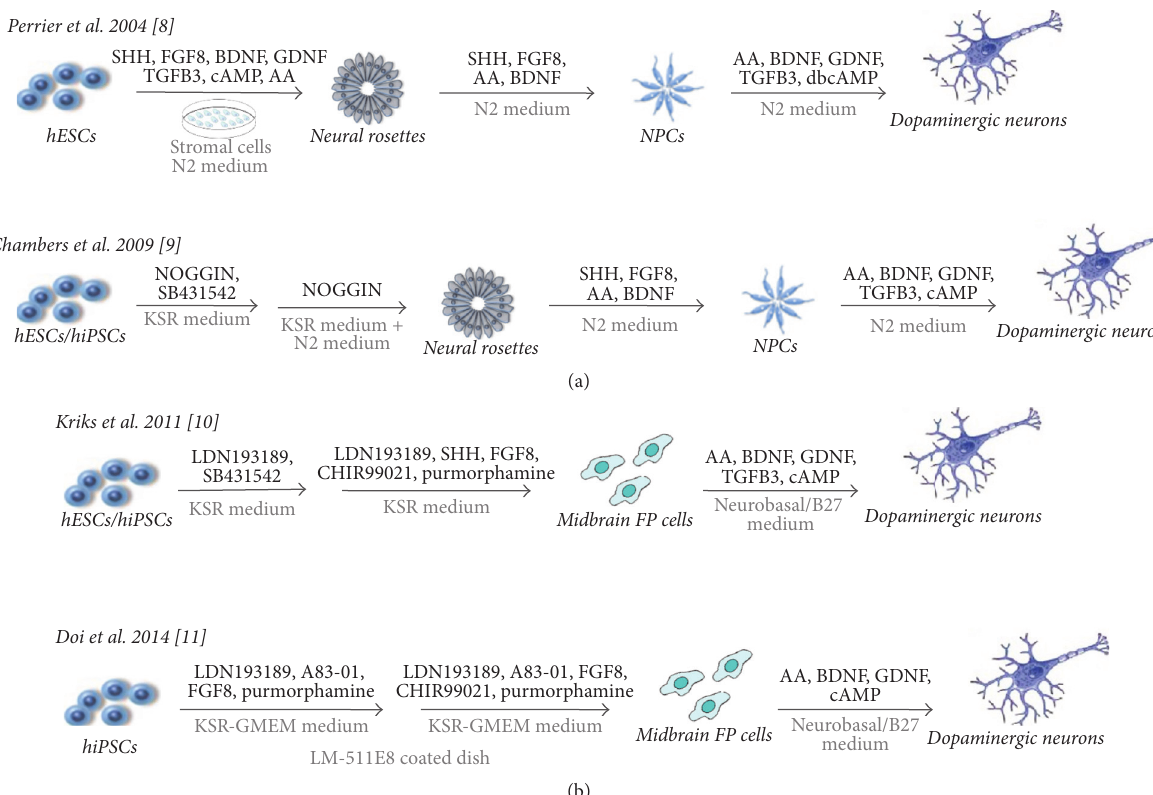
Figure 1: Comparison of different protocols for deriving of midbrain dopaminergic neurons from hESCs and hiPSCs. (a) Methods based on mechanical neural rosettes selection. Neural differentiation was induced by coculture of hPSCs on stromal cells MS5 or S2 [8] and dual inhibitionofSMADsignalingpathway(NOGGIN+TGFBinhibitor:SB431542)inthepresenceofknockoutserumreplacement(KSR)andN2 medium [9]. Rosettes structures were harvested mechanically and gently replated in the presence of growth factors. In the final step, newly generated neural progenitor cells were differentiated into DA neurons in the absence of SHH and FGF8. (b) Methods based on the floor plate (FP) induction. Dual SMAD inhibition (BMP inhibitor: LDN193189 + TGFB inhibitor: SB431542) and activation of WNT signaling by SHH and GSK3B inhibitor (GSK3Bi), CHIR99021, were used for midbrain FP cell generation from hPSCs [10]. Purmorphamine treatment was applied for FP cell patterning. hPSCs induced with LDN193189 and A83-01 (inhibitor of TGFB type I receptor ALK5) were cultured in media supplemented with purmorphamine and FGF8 to induce floor plate cells. FP cells under stimulation with growth factors generated DA neurons; recombinant E8 fragments of human laminin 511 (LM511-E8) supported the neural differentiation and cell survival [11]. Final concentration of growth factors, supplements, and inhibitors may be different in the specified